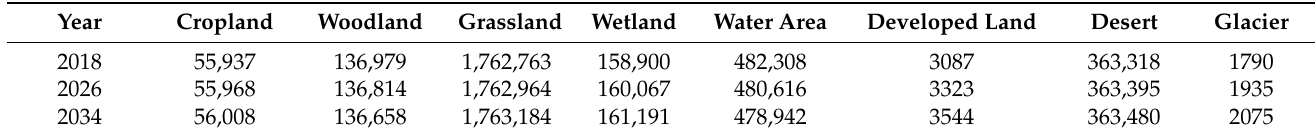
Table 4. Total land demand pixels.